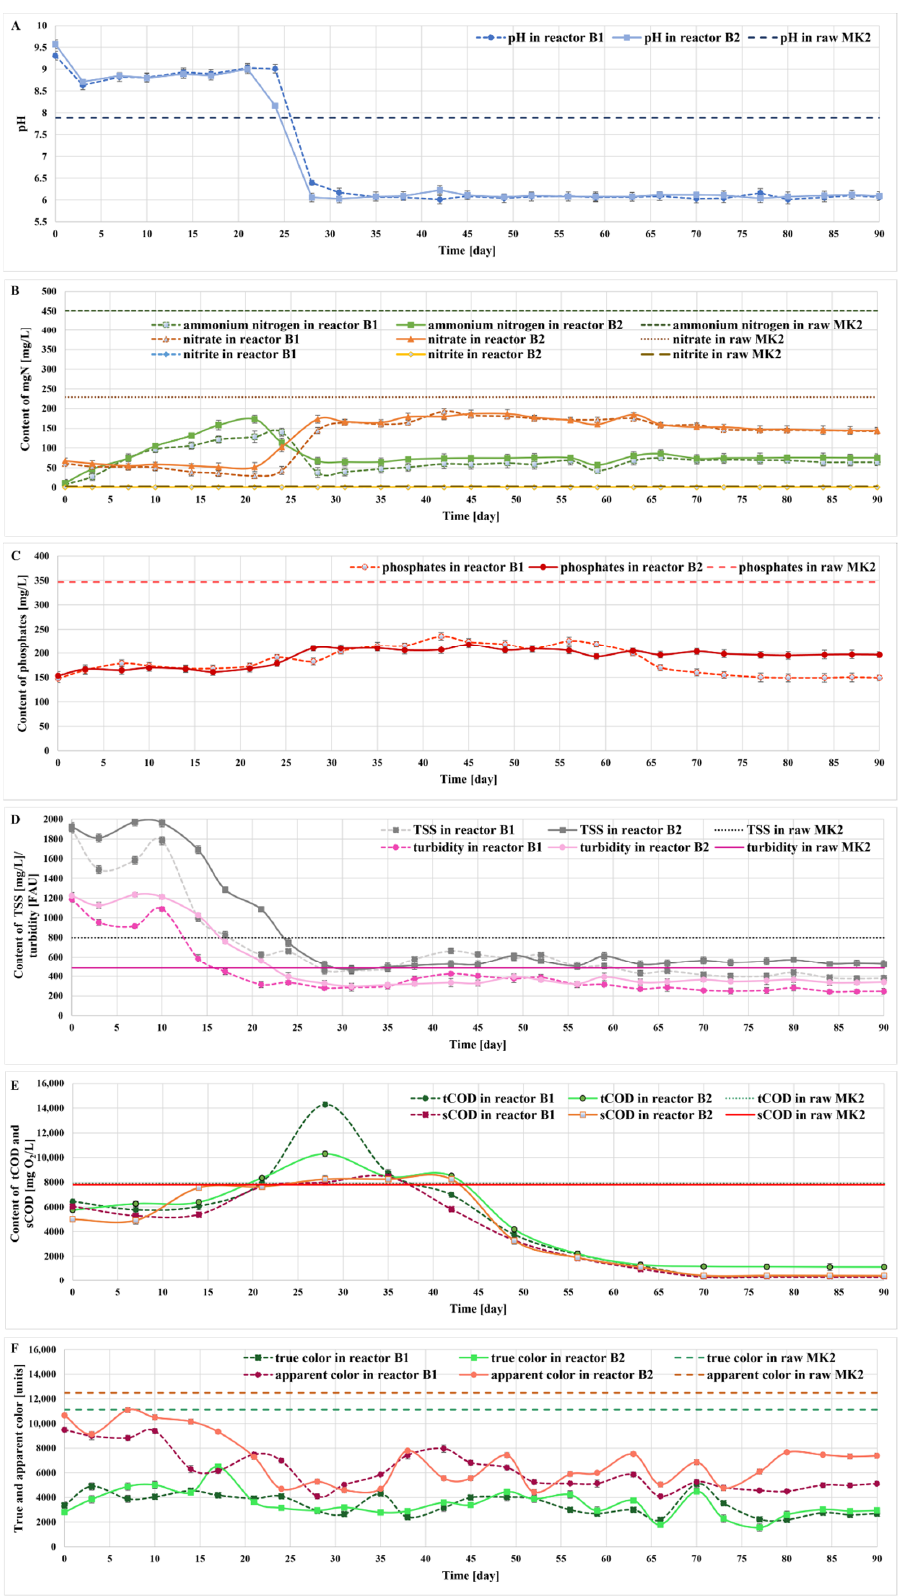
Figure 5. Changes in the pH ( A ), ammonium nitrogen, nitrates, nitrites ( B ), phosphates ( C ), total COD, TSS, turbidity ( D ), soluble COD ( E ), and color ( F ) during the 90-day digestate treatment process in the